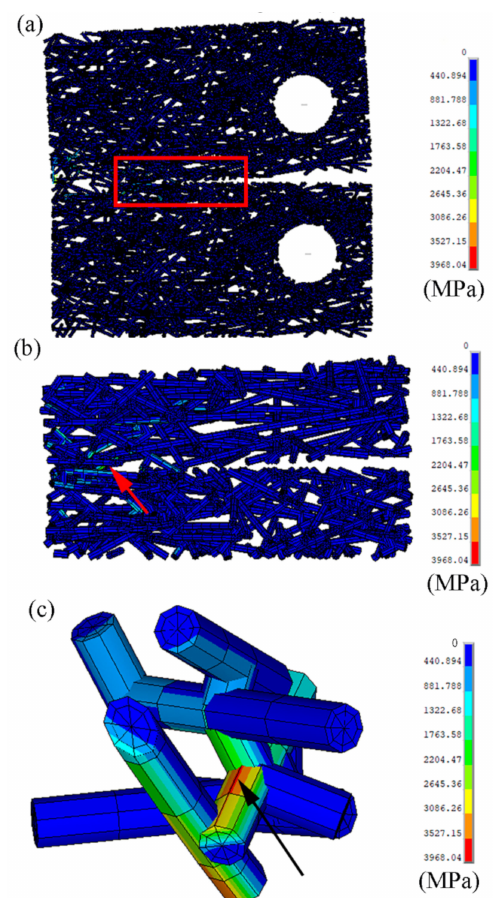
Figure 10. Principal stress contours of ( a ) the FE model with a ratio of 0.5 (the tensile displacement was 0.4 mm), ( b ) the stress contours of the sliced FE model from the red rectangle in ( a ), and ( c) the stress contours of the local structure from the red arrow in ( b ).